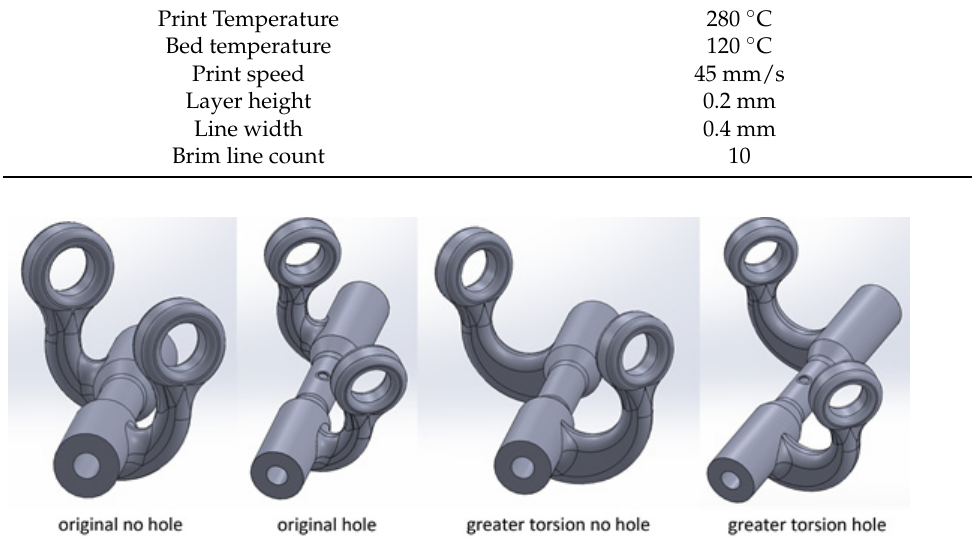
Figure 10. Different test